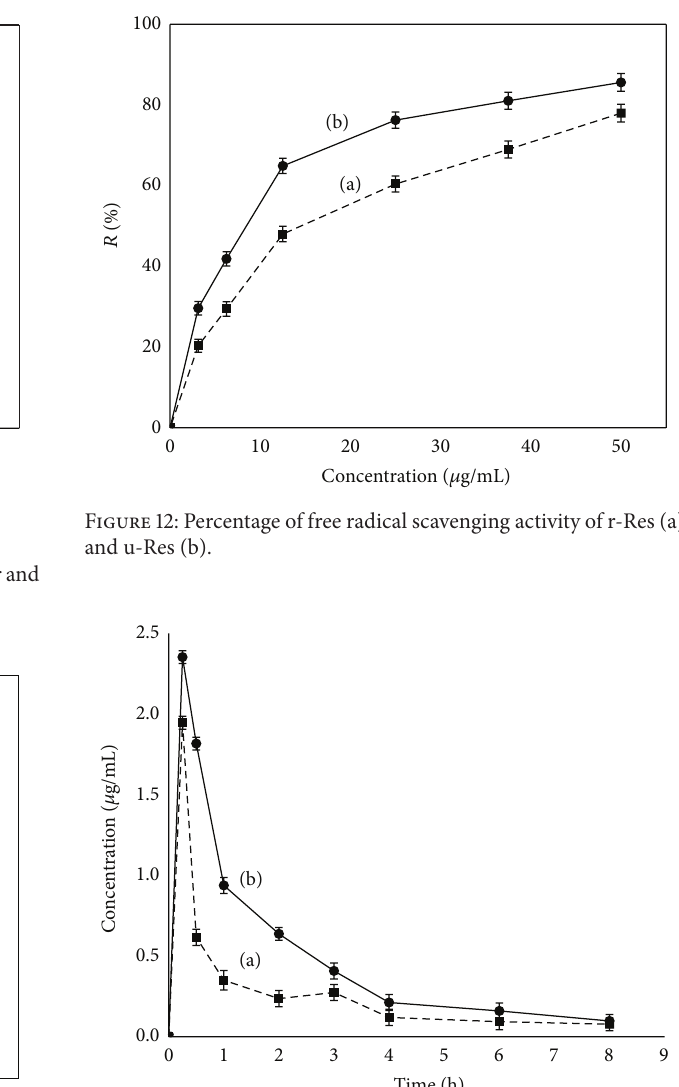
Figure 13: Plasma concentration versus time curve of r-Res (a) and u-Res